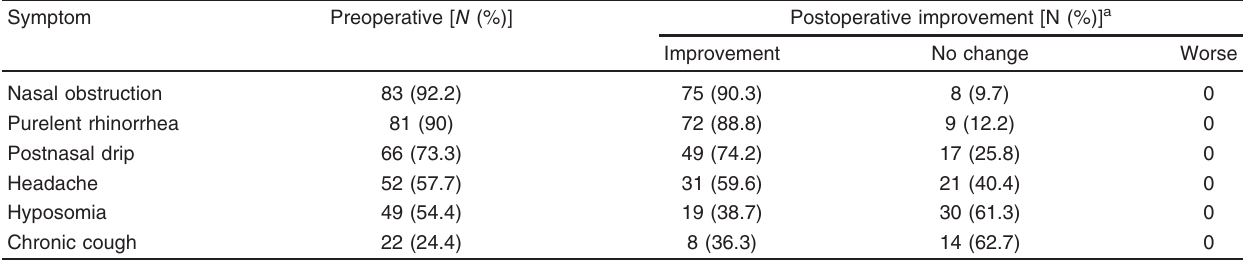
Table 2 Main preoperative symptoms and results of pediatric endoscopic sinus surgery